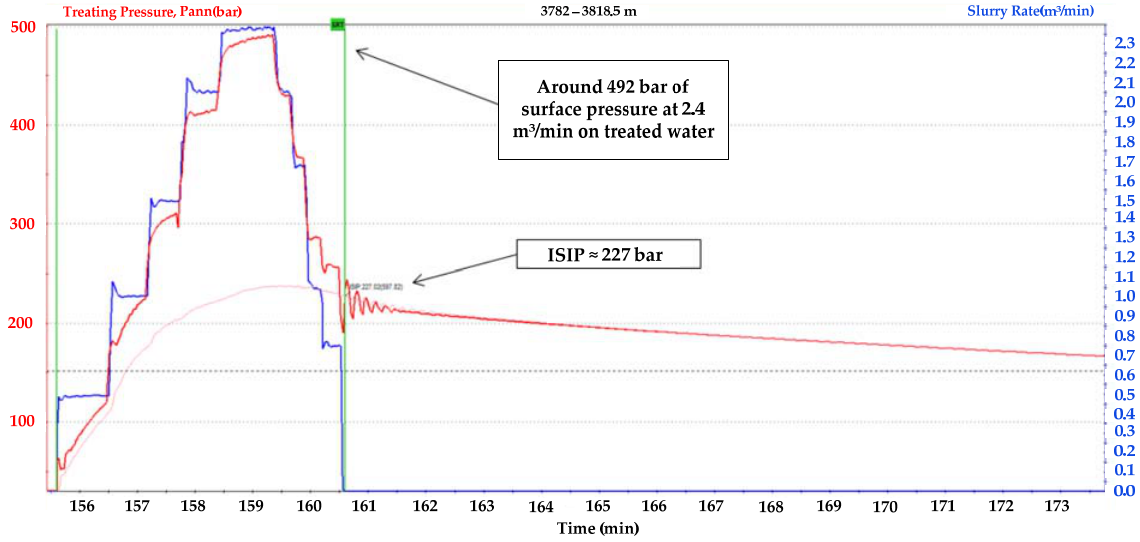
Figure 6. tep rate test (SRT) test diagram